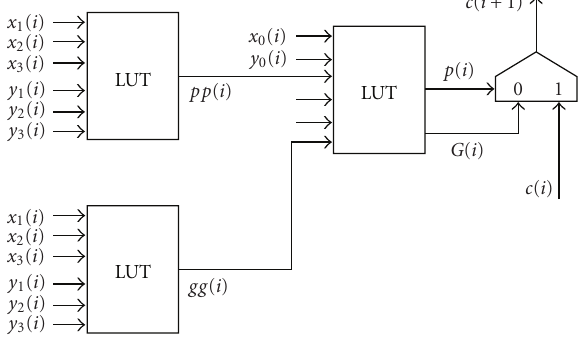
Figure 14: FPGA carry-chain circuit for Ad- II.